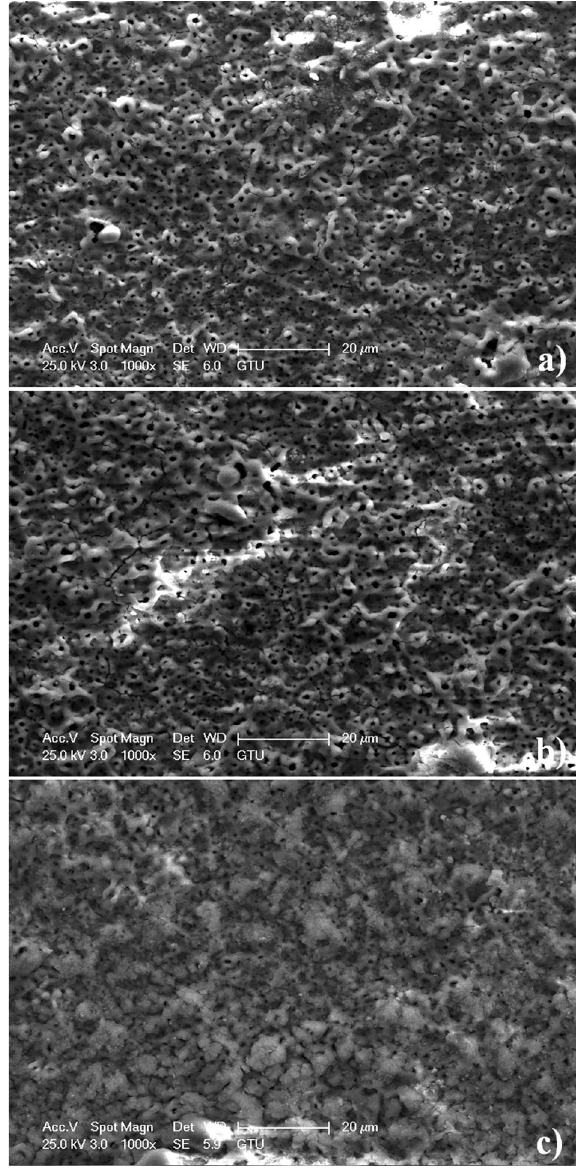
Figure 4. Surface topography of the MAO surfaces taken at low magnifications: ( a ) 15 min, ( b ) 30 min and ( c ) 45